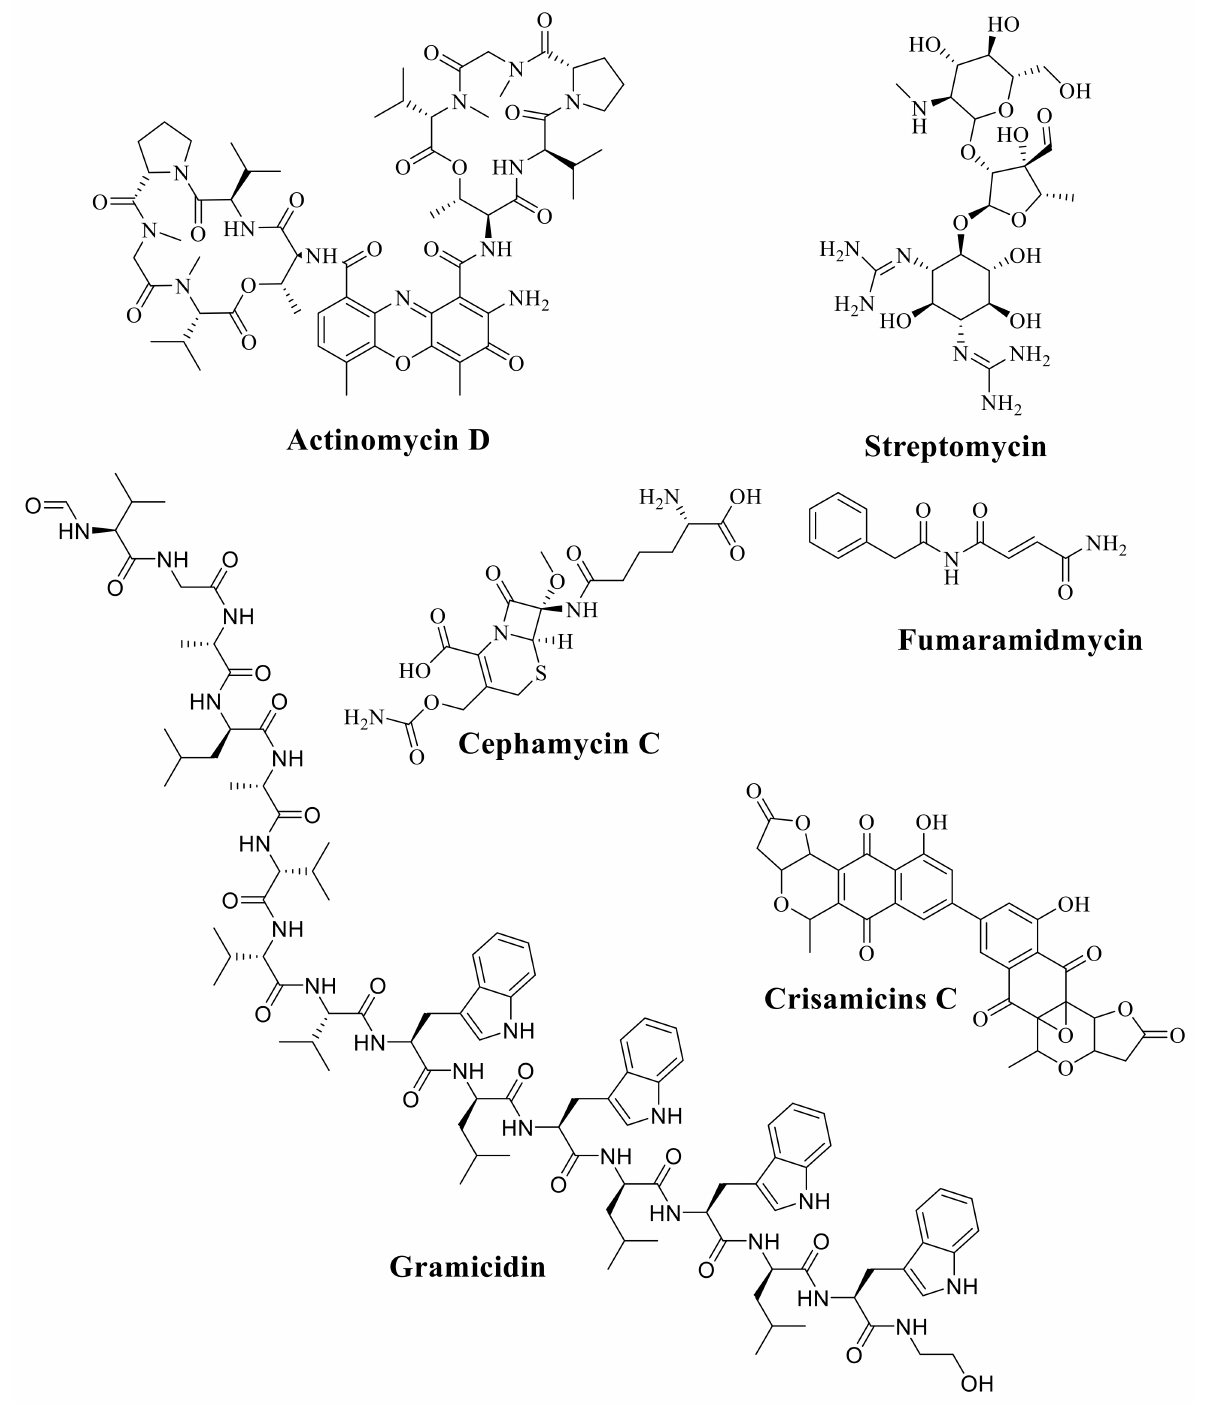
Figure 3. The molecular structure of Actinomycin D; Streptomycin; Gramicidin; Cephamycin C; Fumaramidmycin; and Crisamicins